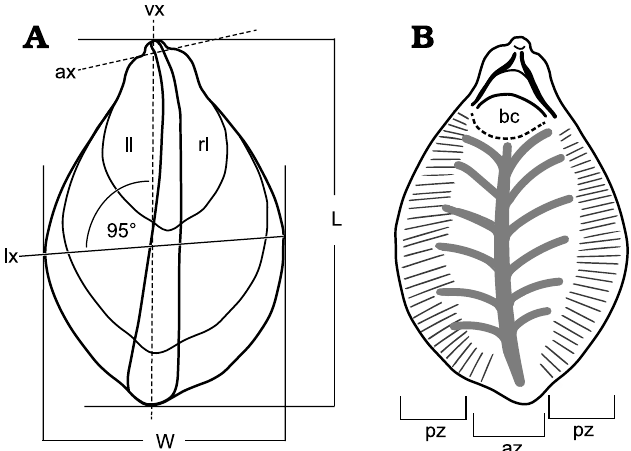
Fig. 3. Orientation, measurements, and ridge zones in Stenothecoides ra­ settii sp. nov. A . Ventral valve, exterior, showing orientation for measure- ments. B . Ventral valve, interior, showing peripheral and axial ridge zones, and approximated body cavity. Abbreviations: ax, auricular axis; az, axial ridge zone; bc, body cavity; L, valve length; ll, left lobe; lx, lobe axis; pz, peripheral ridge zone; rl, right lobe; vx, valve axis; W, valve